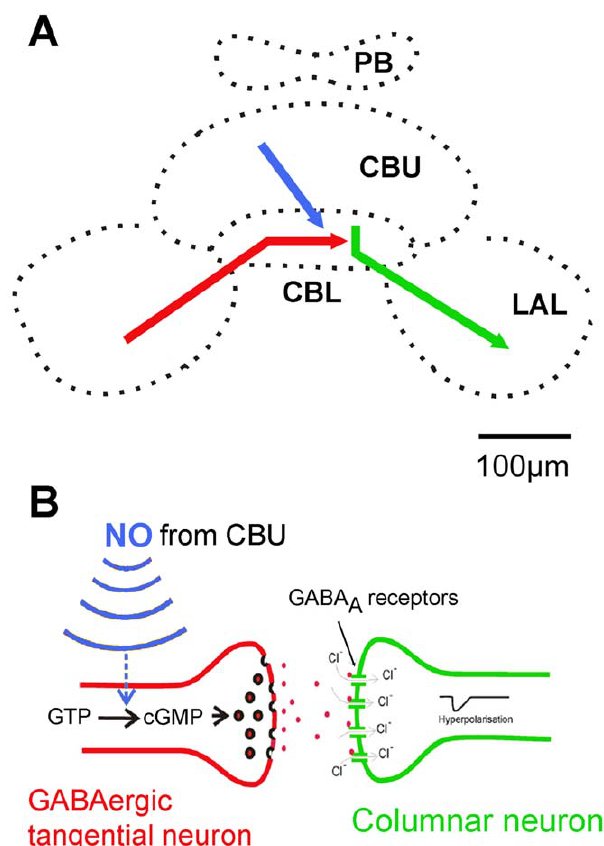
Figure 8. Information flow in the central body with respect to the control of grasshopper sound production. Each type of neuron included represents bilateral groups of several cells. A: Columnar neurons (green) are activated by both nicotinic and muscarinic input from unknown presynaptic neurons. Sufficient cumulative activity of columnar neurons initiates stridulation via direct or indirect activation of descending stridulatory command neurons. Tangential neurons release GABA in the lower division of the central body (CBL) that most likely directly inhibits columnar neurons through picrotoxin-sensitive ionotropic GABA A receptors. Part of the synaptic release of GABA in the CBL is potentiated by nitric oxide (NO) released in the upper division (CBL). B: Three transmitters known to promote (ACh) or suppress (GABA and NO) grasshopper sound production converge on GABAergic synapses in the CBL. NO released from neurites in the CBU activates soluble guanylate cyclase (sGC) in a subpopulation of GABAergic tangential neurons in the CBL. Accumulation of cGMP potentiates GABA release from these tangential cells. The balance of activating and inhibiting inputs to these columnar neurons determines whether sound production will be executed.